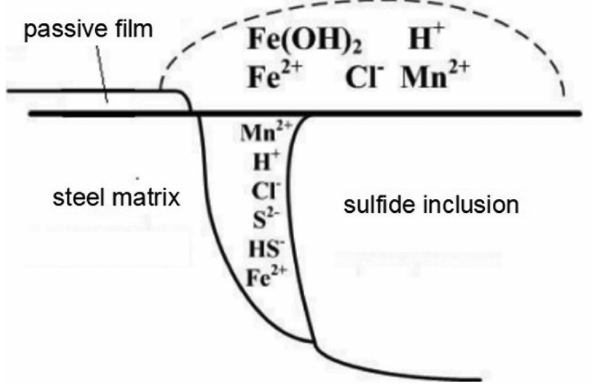
Figure 13: MnS corrosion mechanism